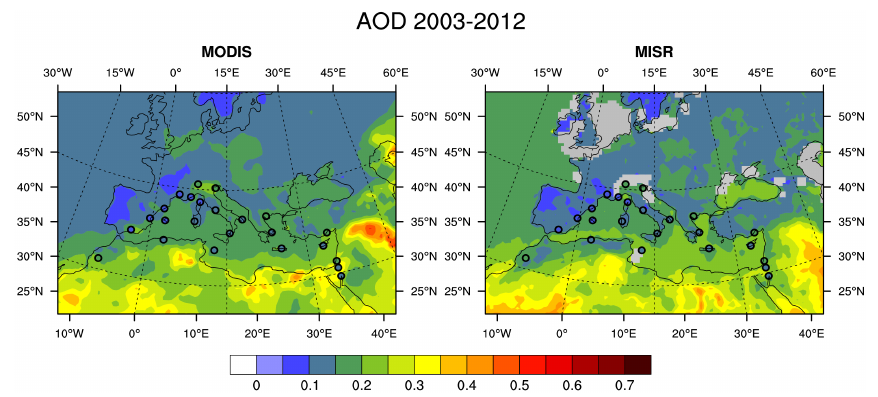
Figure 1. Aerosol optical depth (at 550nm) derived from the MODIS and MISR satellites for the 2003 to 2012 period. The AERONET/PHOTONS AOD is also indicated (in small